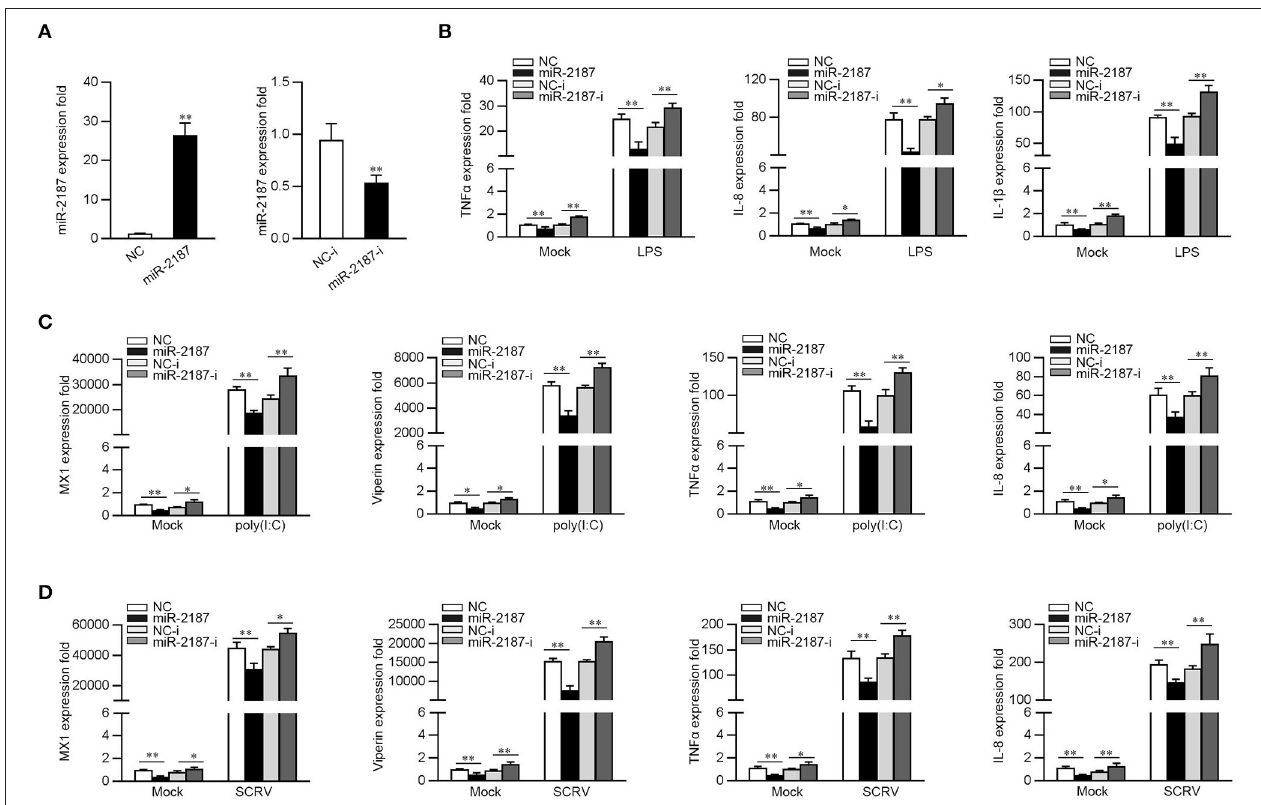
FIGURE 2 | miR-2187 inhibits the expression of inflammatory factors and antiviral genes. (A) MKC cells were transfected with control mimics (NC) or miR-2187 mimics (left panel) and negative control mimics (NC-i) or miR-2187 (right panel) for 48h, the expression of miR-2187 was determined by qRT-PCR and standardized to 5.8S rRNA. (B) MKC cells were transfected with NC, miR-2187, NC-i, miR-2187-i for 48h. Then, the macrophages were treated with LPS for 6h and the expression of TNF- α , IL-1 β , IL-8, and were tested by qRT-PCR and standardized to β -actin. (C,D) MKC cells were transfected with NC, miR-2187 mimics, NC-i or miR-2187-i for 48h, which was stimulated with poly(I:C) or SCRV, and the mRNA level of MX1, Viperin, TNF α , and IL-8 were determined by qRT-PCR normalized to β -actin. All data are presented as the means ± SE from three independent triplicated experiments. ** p < 0.01; * p < 0.05 vs. the